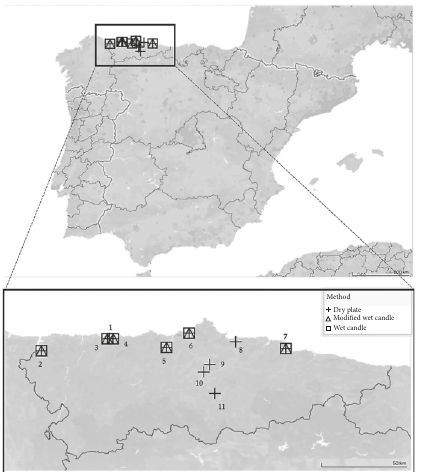
Figure 3: Location of samples in northern Spain distributed for all three different tests.